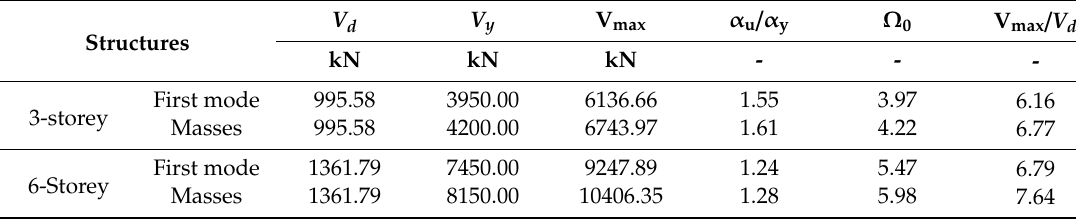
Figure 4. Pushover response curve for examined MRFs. Table 6. Results from puhsover analyses performed on examined